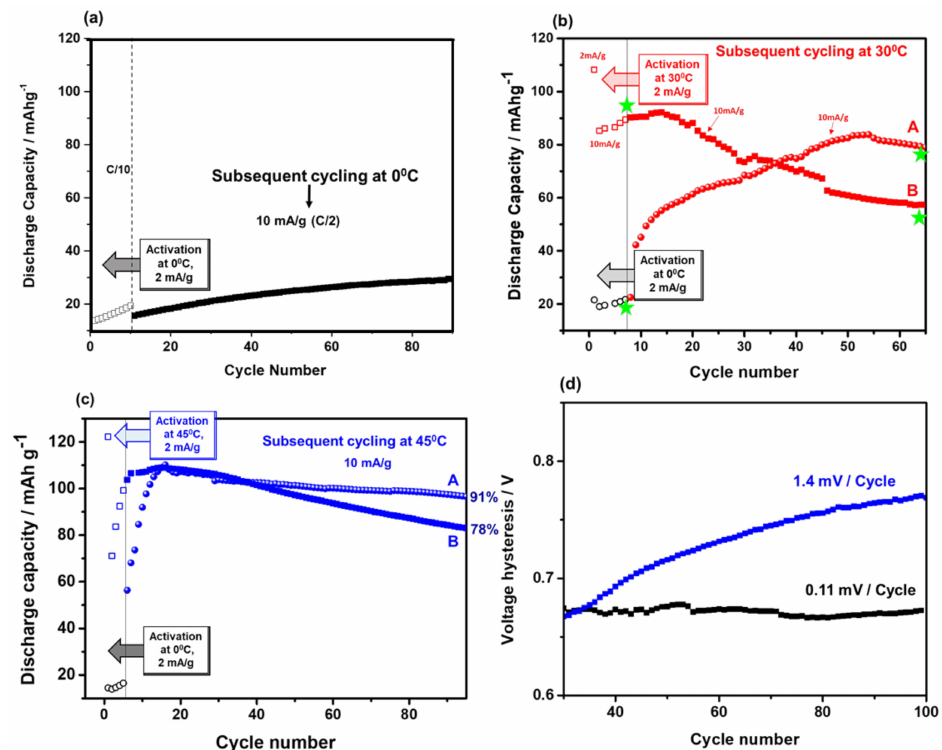
Figure 3. ( a ) Discharge capacity of Li 2 MnO 3 electrodes activated at 0 ◦ C for several initial cycles (empty symbols). Current density was 2 mA / g corresponded to ~C / 10 rate. Subsequent cycles (10 mA /